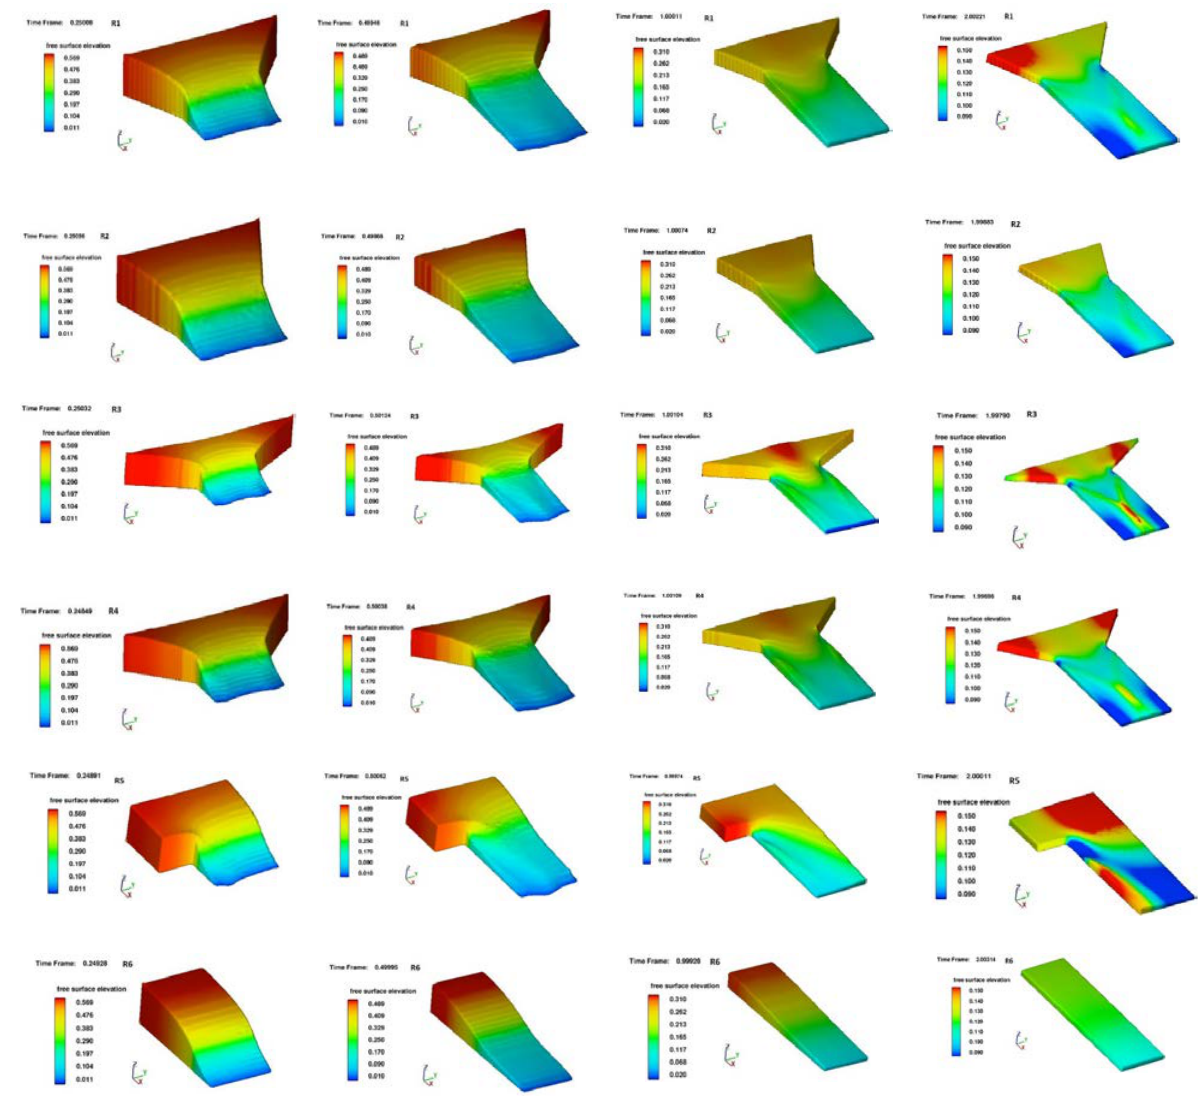
Fig. 10. Free surface elevation for all reservoirs at t= 0.25, 0.5, 1, and 2